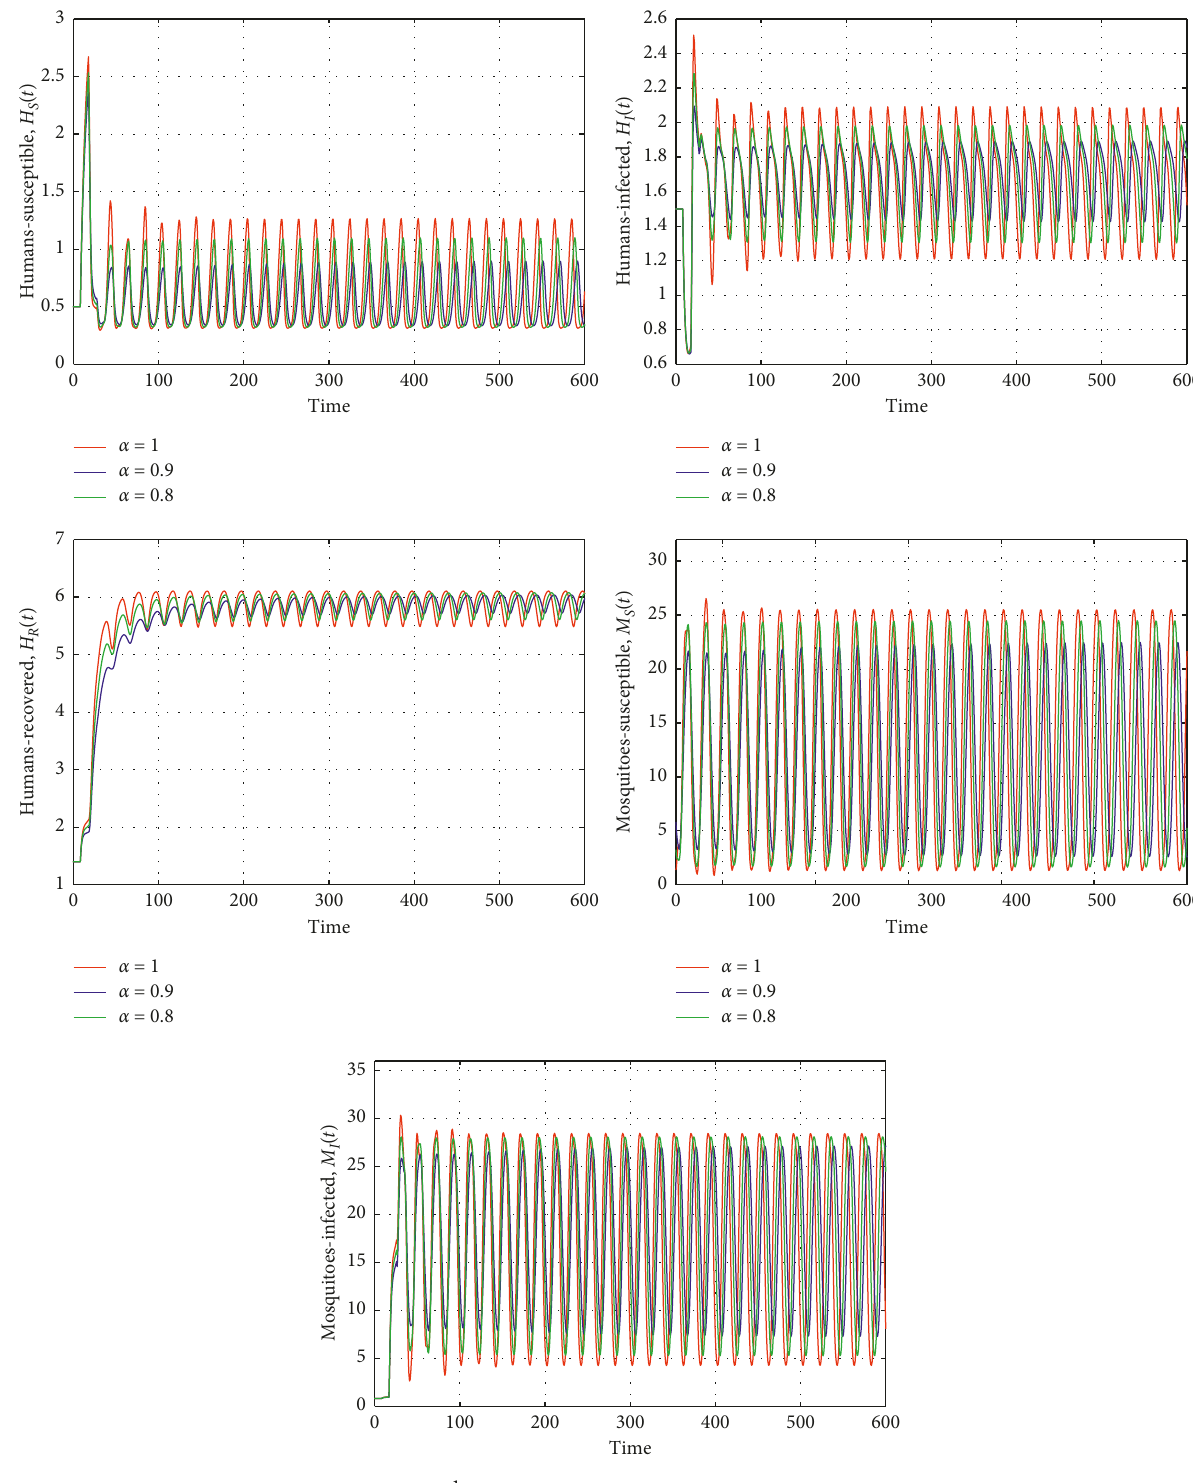
Figure 4: State trajectories for the model (5) for various values of α � 1 , 0 . 9 , and 0 . 8 and τ E ∗ is unstable when τ